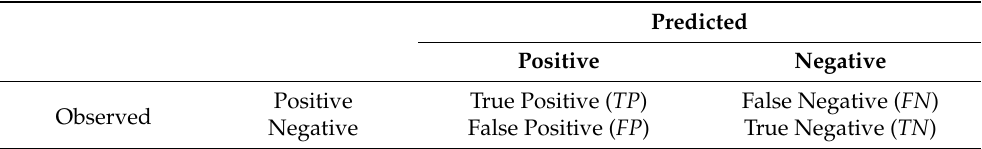
Figure 8. Receiveroperatingcharacteristic(ROC)curveandtheAUCofdifferentmachinelearningmodels. Figure 8. Receiver operating characteristic (ROC) curve and the AUC of different machine learning models. Table 4. Confusion